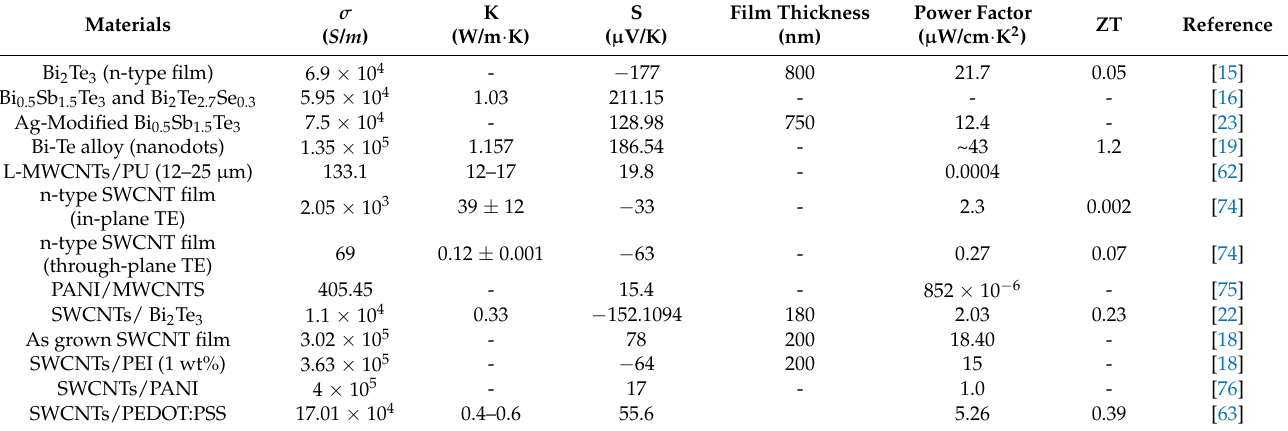
Table 2. Room temperature thermoelectric properties of inorganic and organic thermoelectric materi- als for film-based